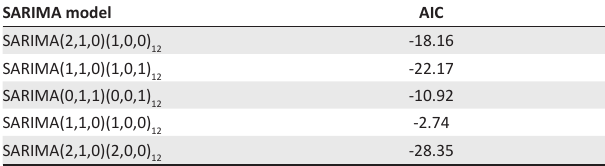
TABLE 1: Seasonal autoregressive integrated moving average model